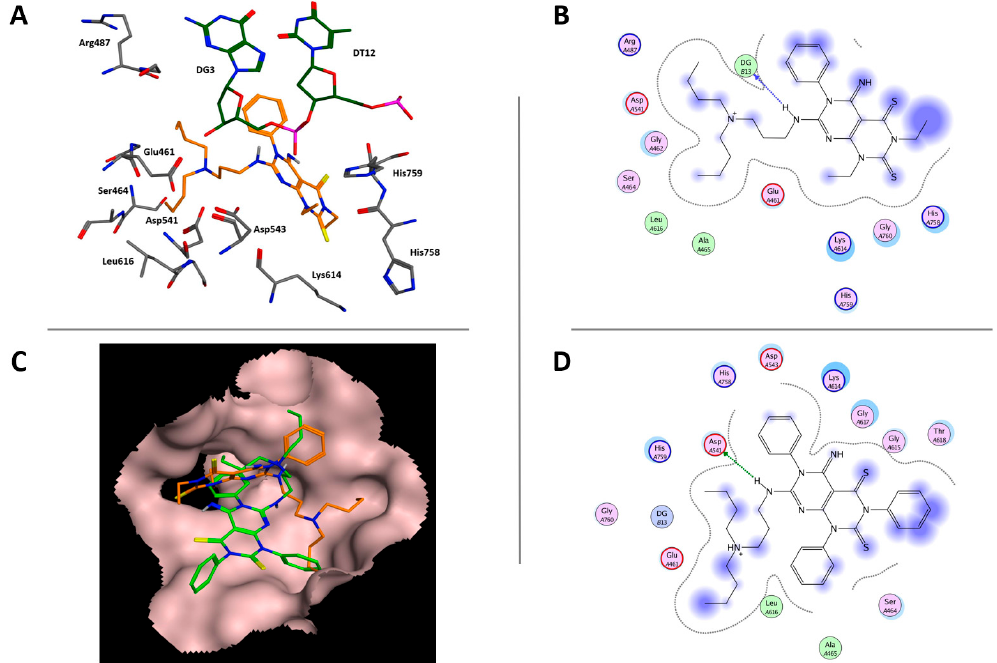
Figure 4. ( A ) Docking pose of 5d within TopoII α binding site. ( B ) Ligplot of TopoII α -DNA- 5b complex. ( C ) different binding orientations of 1d (green carbon atoms) and 5d (orange carbon atoms) in TopoII α binding site. ( D ) Ligplot of TopoII α -DNA- 1b complex.